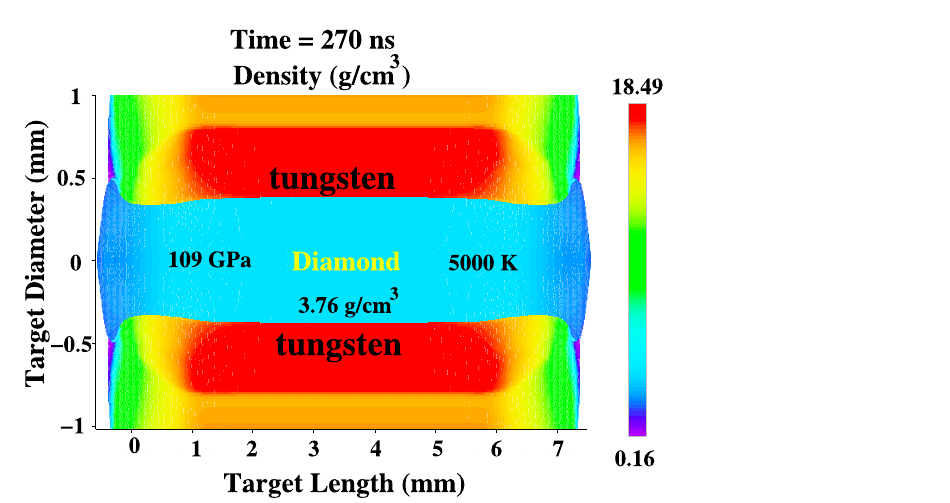
Figure 10. Achieved physical conditions at t = 270